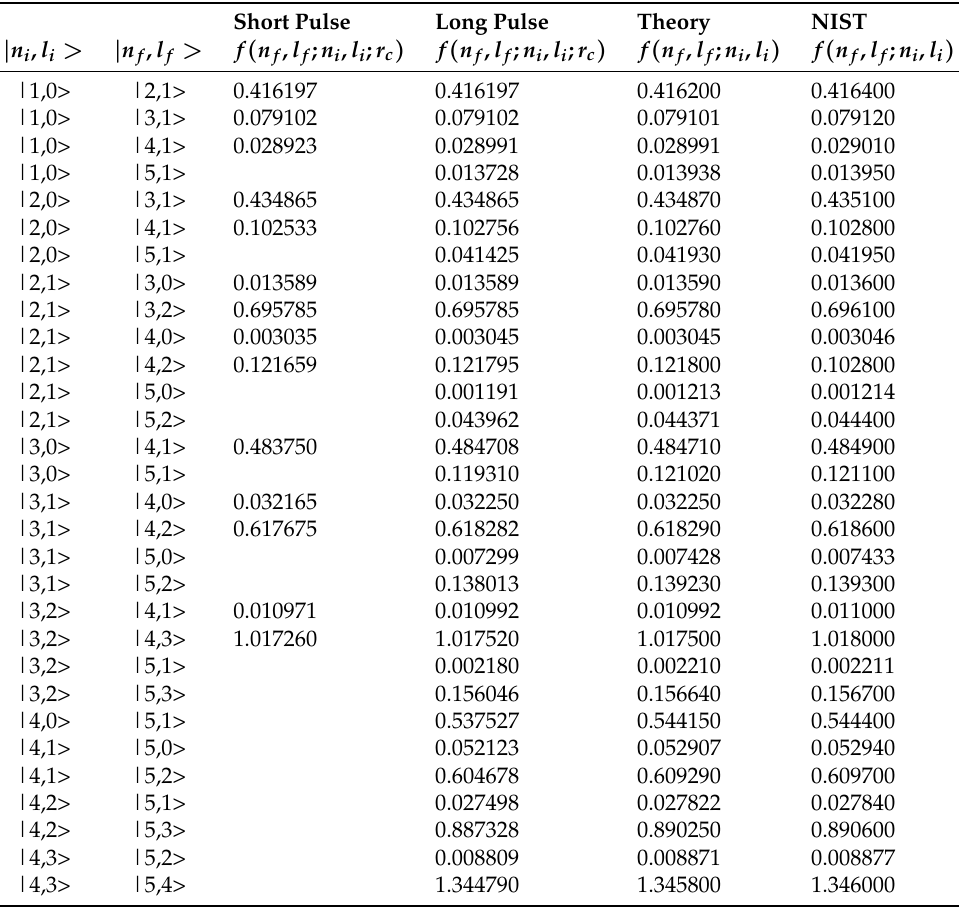
Table 1. The oscillator strength values for the ”short”, Ne = 1.5 × 10 19 cm − 3 , T = 23,000 K, and ”long” pulse, Ne = 6.5 × 10 18 cm − 3 , T = 18,000 K, from [14], as well as a theoretical hydrogen case calculated by code from [18], and NIST spectral database values